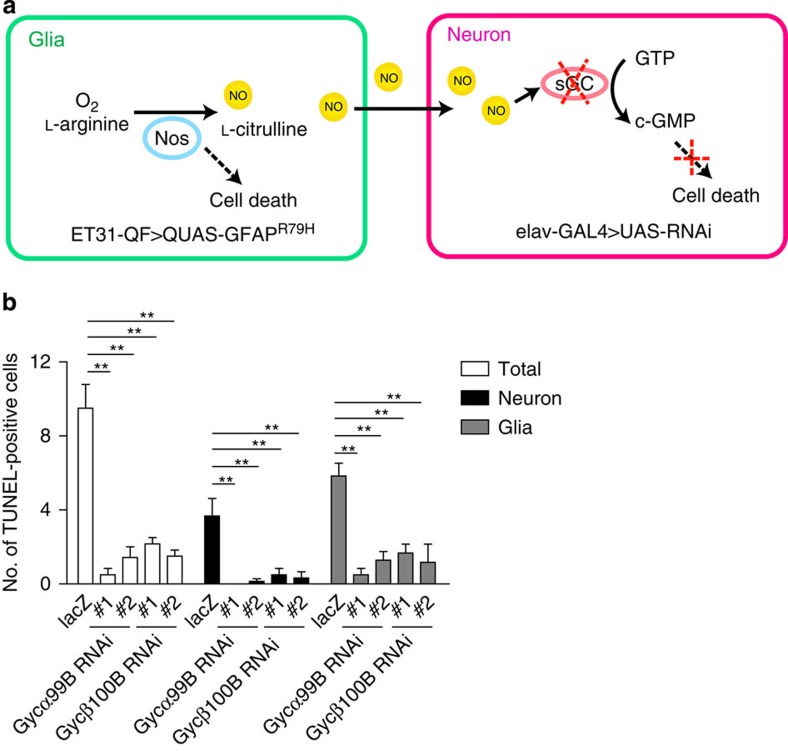
Knockdown of soluble guanylyl cyclase (sGC) in neurons reduces GFAP toxicity.(a) Schematic diagram of the dual-transcriptional system. To independently manipulate gene expression in glia and neurons, the GAL4/UAS system and the Q system are used together. GFAPR79H (QUAS-GFAPR79H) is expressed in glia with the Q system glial-specific driver ET31-QF (green box) and RNAi lines (UAS-RNAi) targeting sGC are expressed in neurons with the GAL4/UAS system neuronal-specific driver elav-GAL4 (pink box). Nitric oxide synthase (Nos) produces NO in glia from L-arginine and O2. NO diffuses to neighbouring neurons and activates sGC, which converts GTP to cGMP. By expressing RNAi directed to sGC in neurons, NO signalling is blocked. (b) Knockdown of two Drosophila sGC subunits, Gycα99B and Gycβ100B, with independent RNAi lines, markedly reduces the number of TUNEL-positive cells in GFAPR79H transgenic flies (total, left). Both neuronal (middle) and glial (right) cell death are rescued by reducing expression Gycα99B and Gycβ100B in neurons. **P<0.0001, compared with UAS-lacZ control, F=15.32; 11.62; 10.15; df=29; 29, 29. one-way ANOVA with Tukey's multiple comparison test, n=6 per genotype. Flies were 20 days old. Genotype: elav-GAL4; ET31-QF; QUAS-GFAPR79H/UAS-RNAi. RNAi lines are indicated in the figure label.